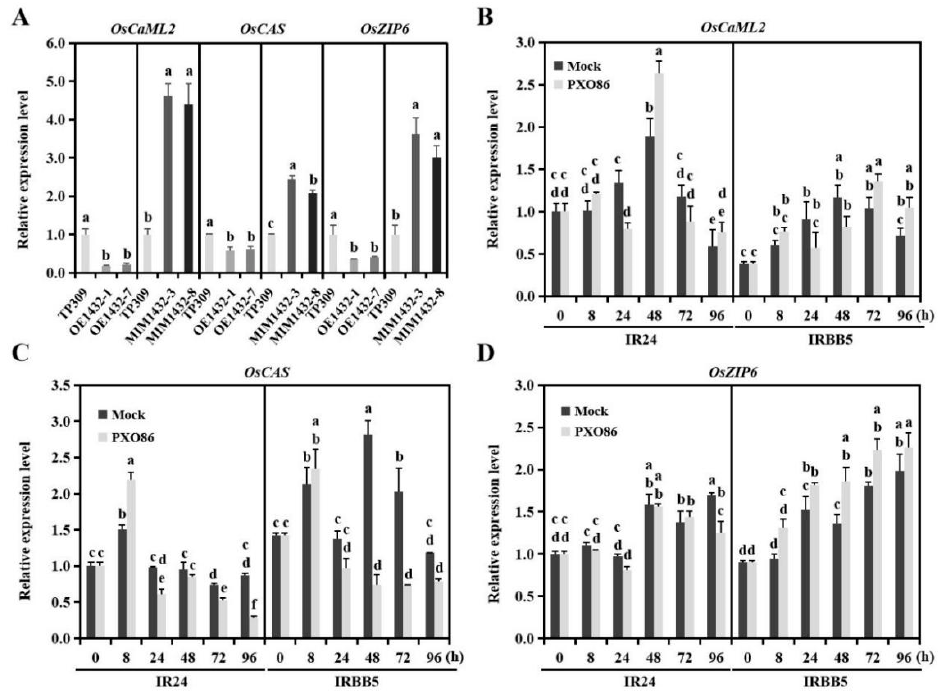
Figure 4. The candidate targets of osa-miR1432 have differential expression profiles in susceptible and resistant genotypes upon Xoo infection. ( A ) The relative expression levels of the candidate targets in the OE1432 and MIM1432 lines. ( B – D ) The expression pattern of OsCaML2, OsCAS and OsZIP6 in susceptible and resistant genotypes upon Xoo or mock treatment. Error bars indicate standard deviation ( n = 3). Different letters above the bars indicate significant differences ( p < 0.01) determined by one-way analysis of variance (ANOVA) followed by post hoc Tukey HSD analysis.